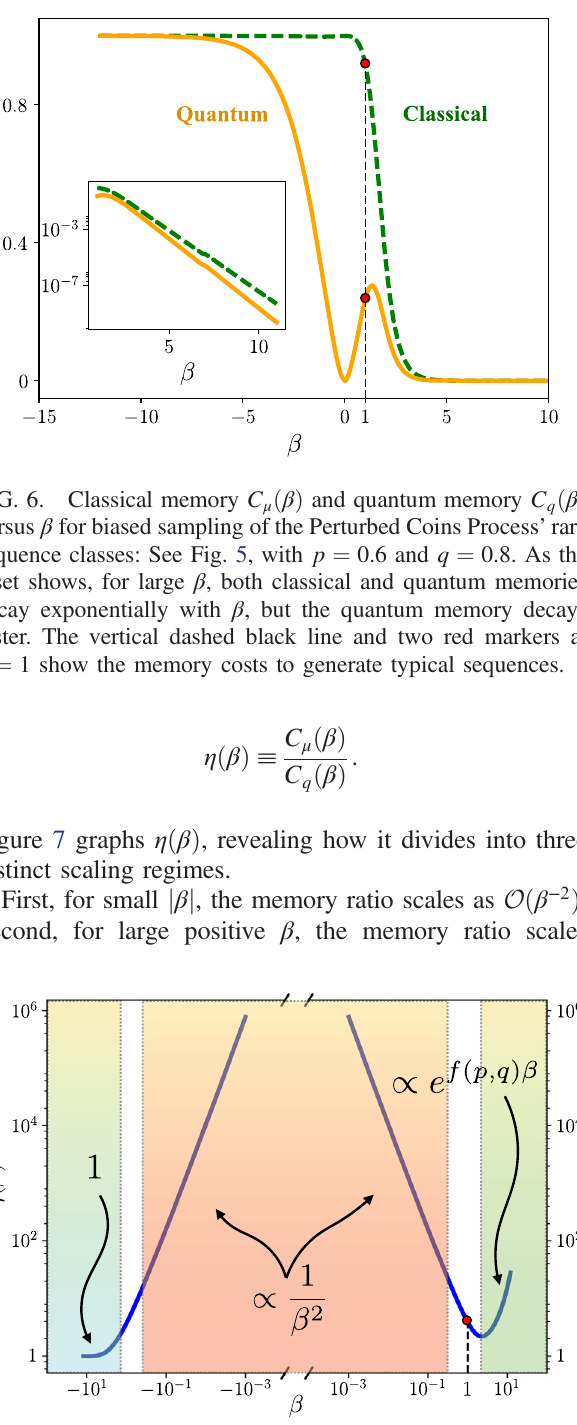
FIG. 7. The classical-to-quantum memory ratio for generating rare realizations of the Perturbed Coins Process with p ¼ 0 . 6 and q ¼ 0 . 8 when employing its q -machine instead of its (classical) ϵ - machine. Three different advantages occur: (i) near β ¼ 0 the ratio scales as O ð β − 2 Þ ; (ii) for large positive β , it scales exponentially with β , O f exp ½ f ð q; p Þ β (cid:3)g ; and (iii) no advantage occurs at large negative β . The vertical dashed black line and red marker at β ¼ 1 show the memory advantage for generating typical